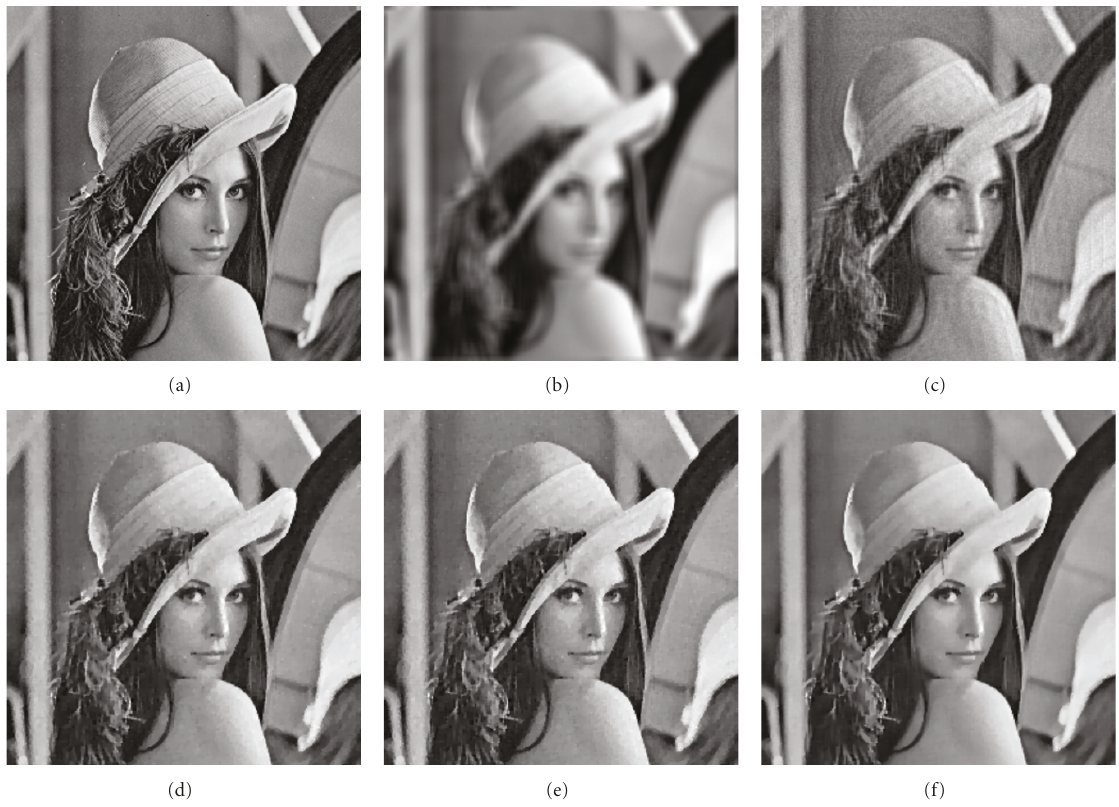
Figure 2: (a) Original “Lena” image. (b) Degraded “Lena” image (SNR = 6 . 65) with 9 × 9 uniform blur and additive white Gaussian noise (local variance = 0.1663). (c) Wiener filter restoration. (d) TV prior Bayesian restoration. (e) Nonquadratic Huber prior Bayesian restoration. (f) The proposed SA prior Bayesian restoration.